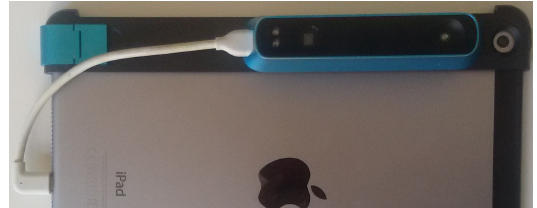
Figure 1: The Structure Sensor and the Apple iPad Air 2 tablet used to perform the